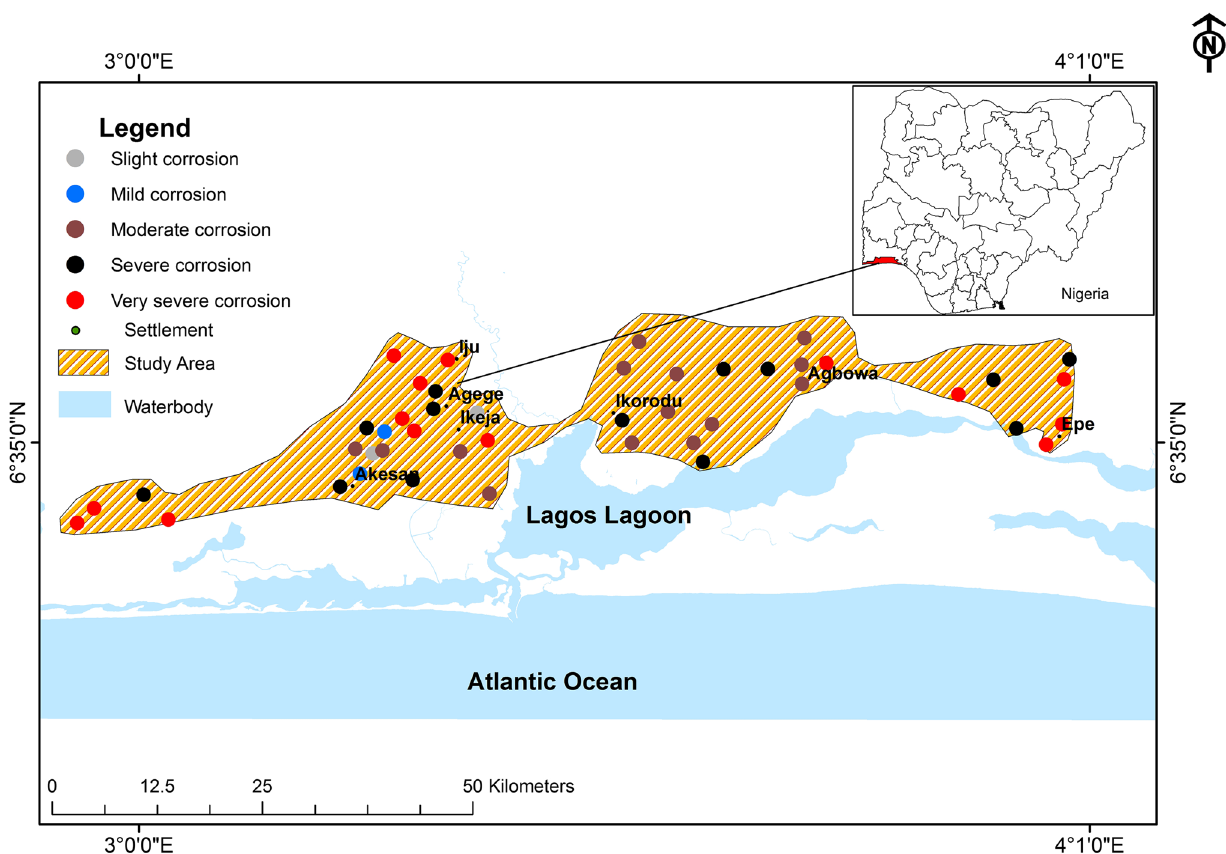
Fig. 8 Distribution of Langelier index in the dry